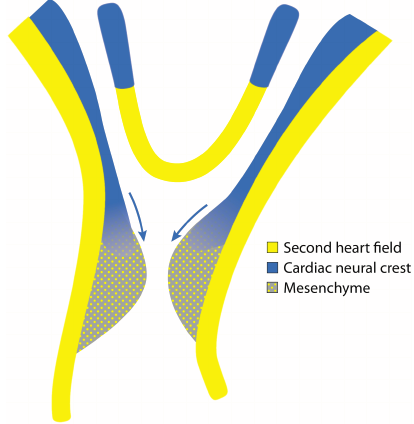
Figure 4. Remodeling of the endocardial cushions. Cardiac neural crest cells (blue) provide paracrine signals to second heart field cells (yellow) to orchestrate apoptosis (depicted as dark gray cells) and changes in extracellular matrix production during semilunar valve remodeling. Modified from